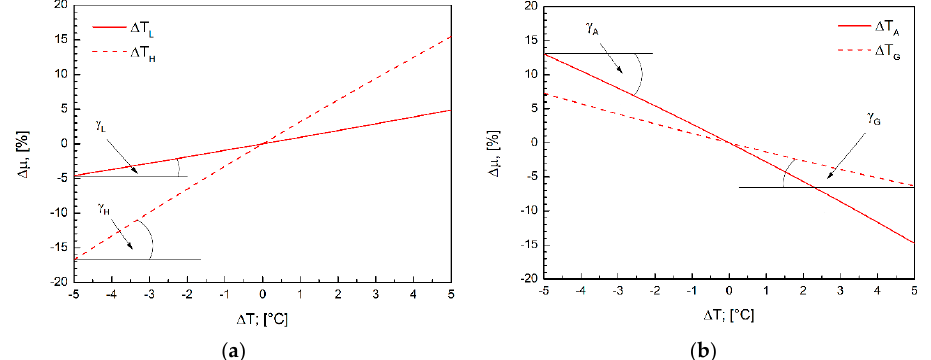
Figure 4. Variation of the thermo-chemical instability in comparison with the reference case: ( a ) evaporation temperature and condensation temperature changed by ± 5 °C; ( b ) absorber temperature and generator temperature changed by ± 5